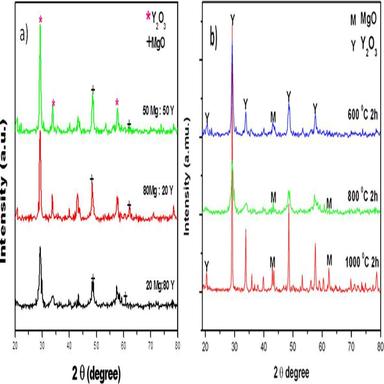
The XRD pattrens of (a) the produced MgO-Y2O3 nanocomposite at diferent Mg2+ ion content annealed at 600 C for 2 h and (b) the optimization of annealing parameters for the nanocomposite phase of MgO-Y2O3.